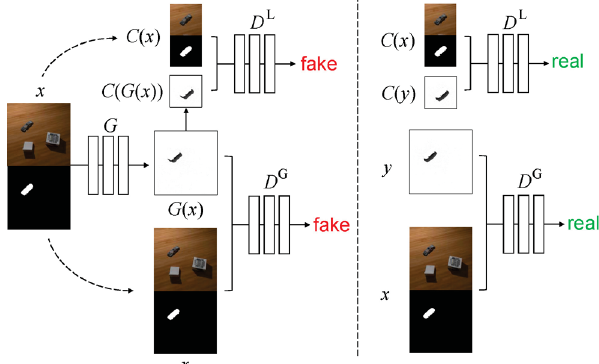
Fig. 2 Training a conditional generative adversarial network to synthesize shadow maps. The local discriminator D L learns to classify between fake and real cropped tuples. The global discriminator D G learns to classify between fake and real tuples from a global view. The generator G learns to fool the